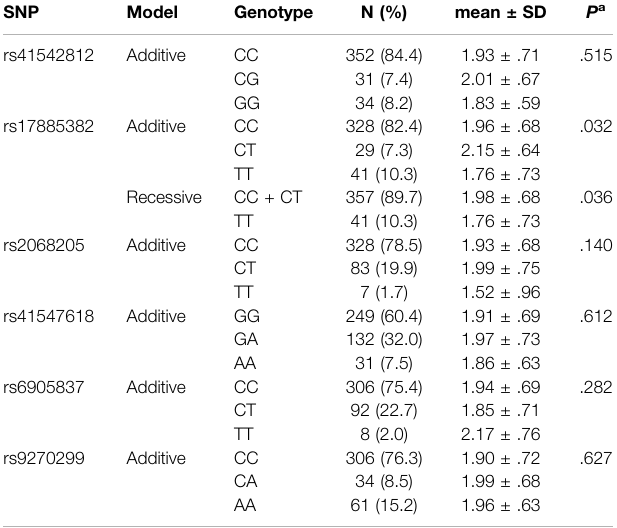
TABLE 5 | Results of covariance analysis for B/Victoria antibody